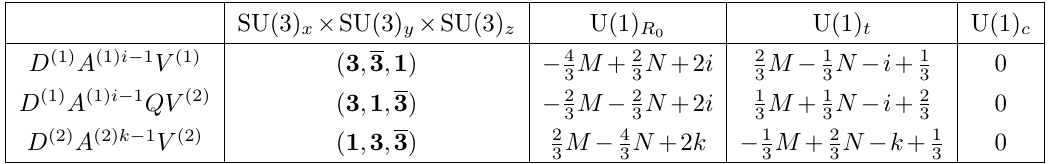
Table 6 . Examples of the gauge invariant operators. Contractions of all color indices are under- stood.